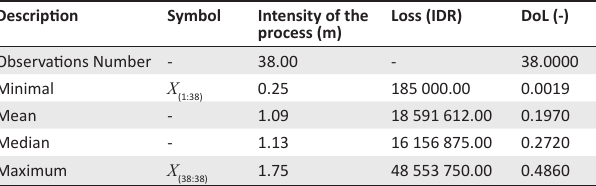
DoL, Degree of loss; IDR, Indonesian